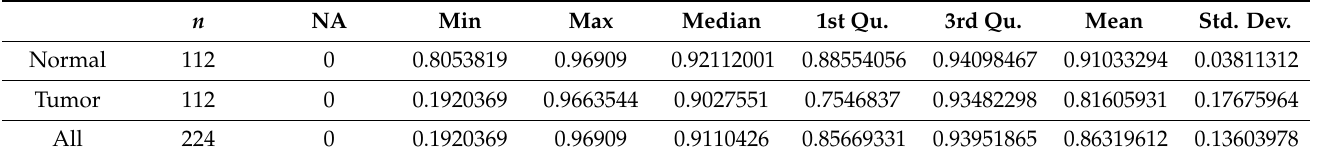
Table 2. Colorectal β -values and statistics.